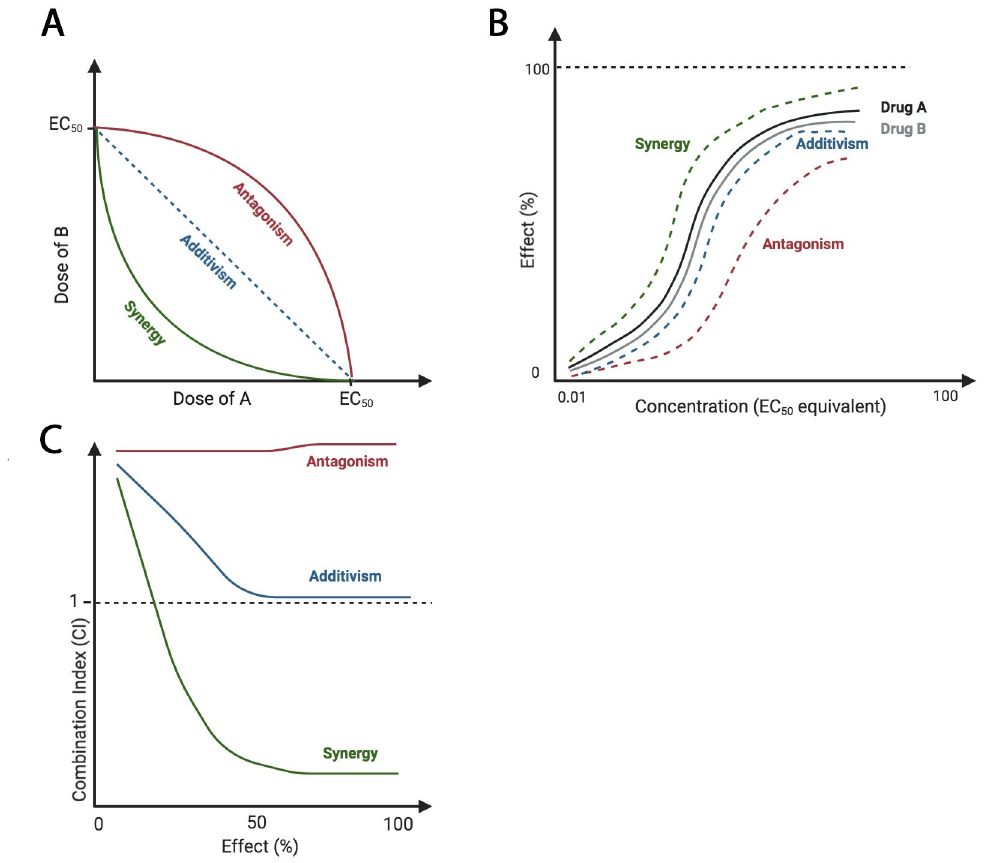
Fig 1. Theoretical isobologram, curve shift, and combination index analyses of drug–drug interactions. Antagonistic relationships require increased dosage of drugs for the same individual effects, additive effects require the same dosage of drugs for the same individual effects, and synergistic interactions require decreased dosage of drugs for the same individual effects. (A) Isoboles connect the points of EC 50 of each drug, A and B. If the drugs are synergistic, the EC 50 of agent A in the presence of B should be lower than that of agent A alone. (B) Curve shift analysis reveals a leftward shift, indicating synergy, or a rightward shift, indicating antagonism. This corresponds to changes of EC 50 . (C) CI values less than, equal to, or greater than 1 indicate synergy, additivism, or antagonism, respectively. Images created with BioRender.com. CI, combination index; EC 50 , half maximal effective